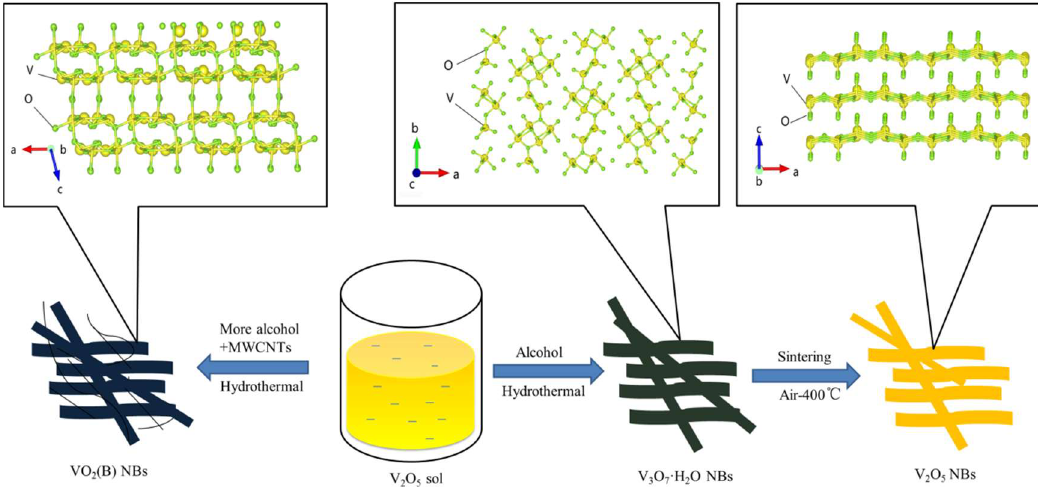
Figure 1. Schematic diagram for preparation of V 3 O 7 · H 2 O NBs, VO 2 (B) NBs / MWCNTs and V 2 O 5 NBs as well as their corresponding molecular crystal structures.